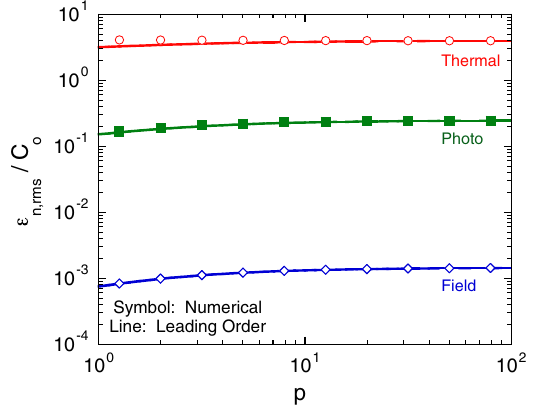
FIG. 9. Behavior of the ratio ε as calculated using Eq. (52) n; rms with C as a function of the time parameter p ¼ t= τ for the o representative fields ½ F (cid:2) of each mechanism ( x ¼ T , F , ω ). The x (red) solid line labeled “ Leading Order ” refers to the ratio of Eq. (53) with C of Eq. o